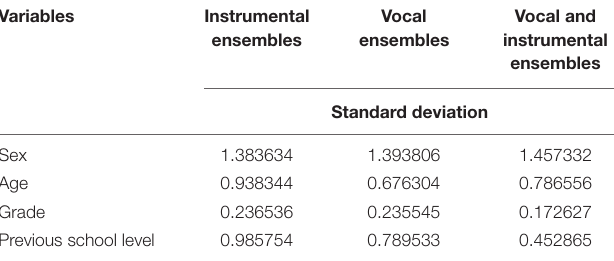
TABLE 3 | Level of differences in demographics.